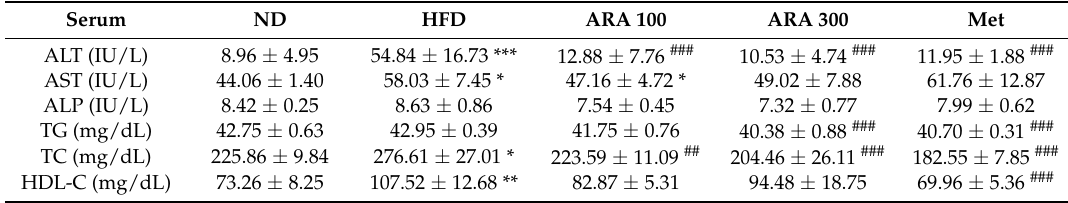
Table 1. Effect of Atractylodis Rhizoma Alba (ARA) on serum